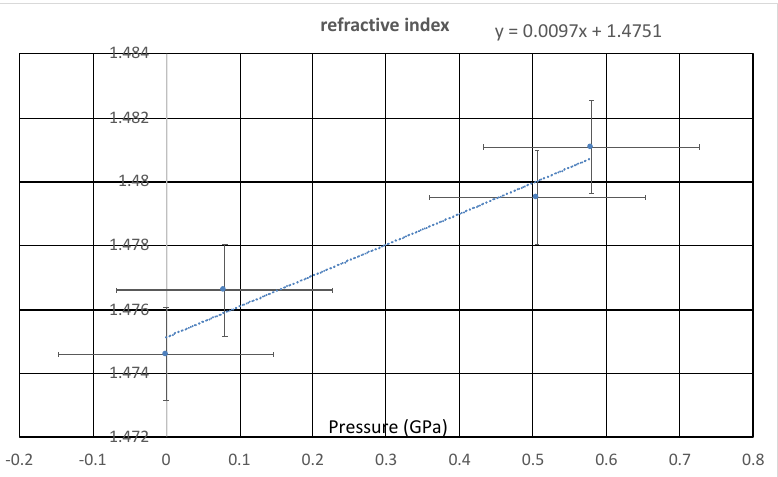
Figure A3. Data from Jae-Hyeon Ko of [42]; used with their permission. See text for